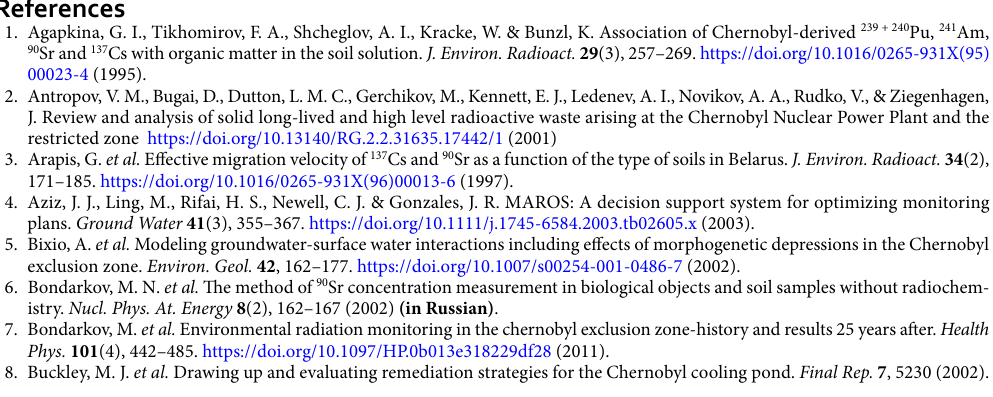
Table 2. Certified reference solutions of radioactive labels used in analytical studies of actinide elements.